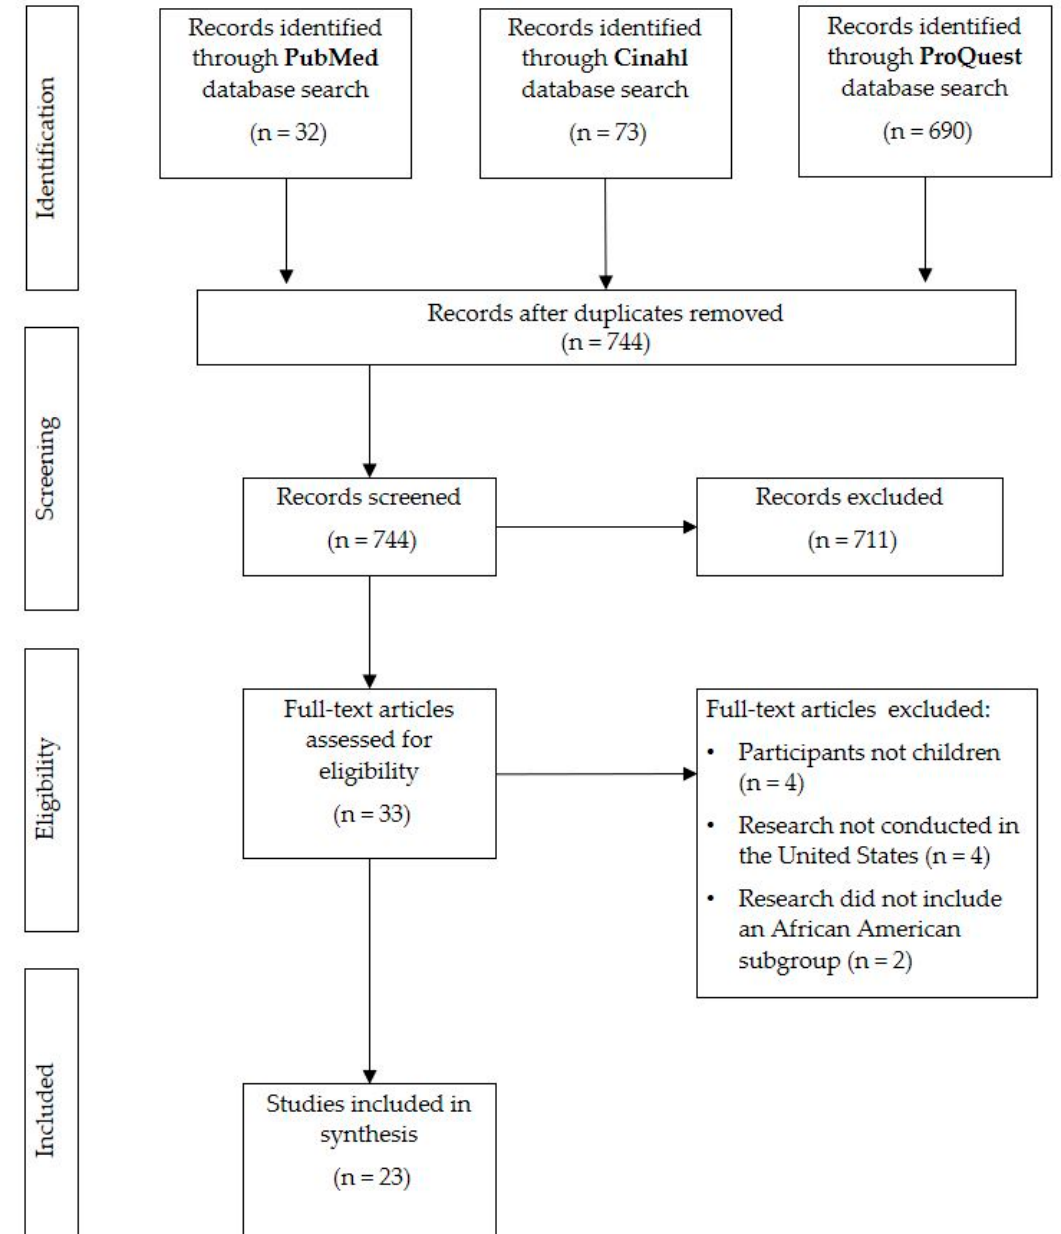
Figure 1. PRISMA Figure 1. PRISMA flowchart.